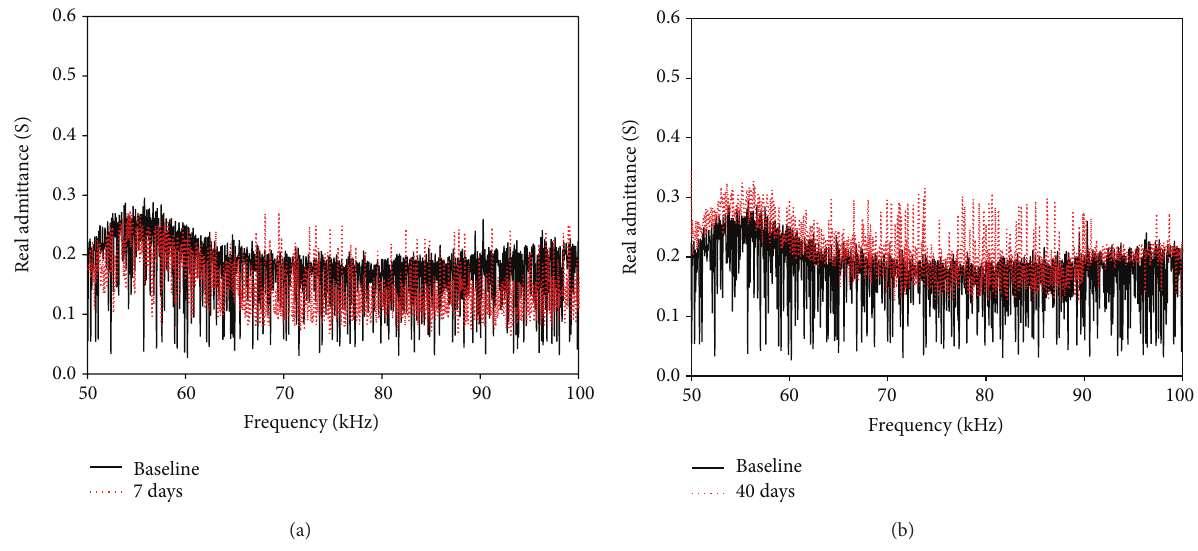
Figure 17: Real admittances of PZT1 in the frequency range of 50–100 kHz: (a) 7 days and (b) 40